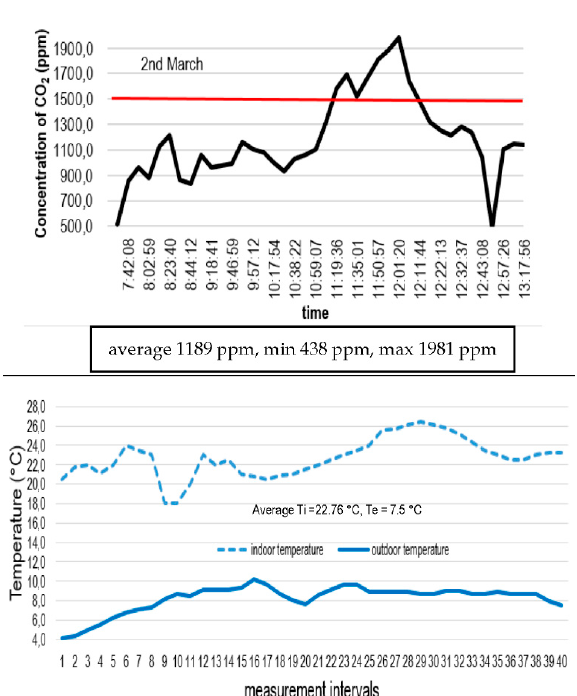
Figure 6. Daily profiles of CO 2 concentration and indoor/outdoor temperatures (2nd March).